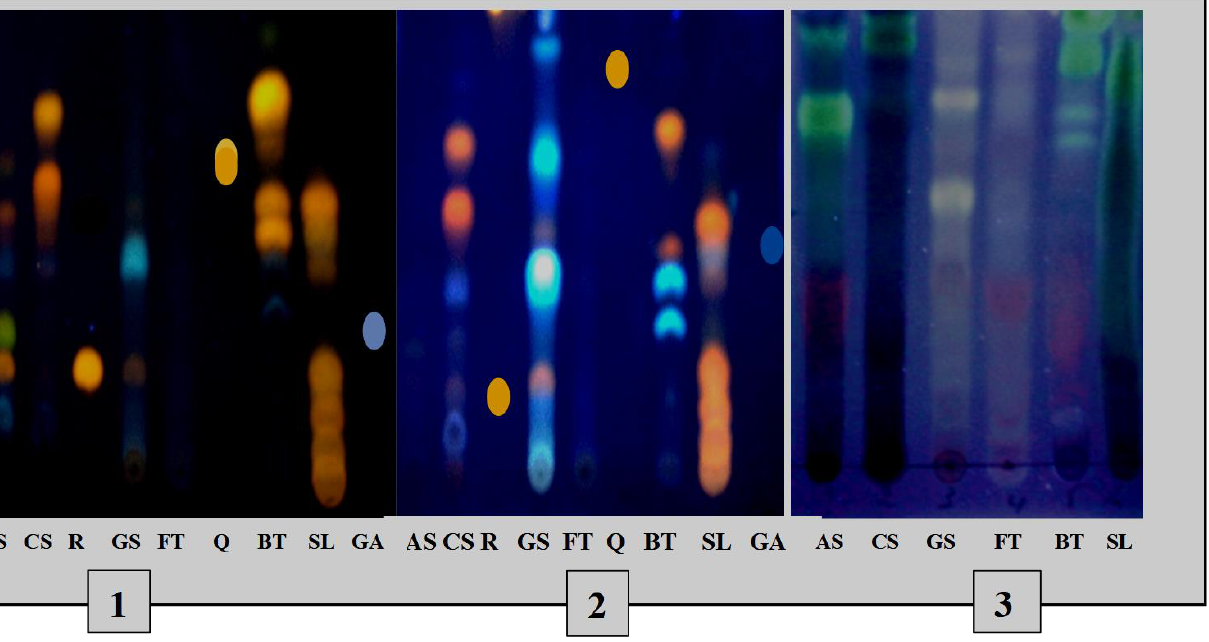
Figure 3. TLC profiles of phenolic and terpene compounds of the species studied. 1: TLC profile of phenolics from decocted extracts; 2: TLC profile of phenolics from macerated extracts; 3: chromatogram of triterpenes and steroids. As: A. senegalensis ; Cs: C. sieberiana ; R: rutin, Gs: G. sokotensis ; F.t: F. thonningii , Q: quercetin, B.t: B. thonningii , S.l: S. longepedunculata , GA: gallic acid.